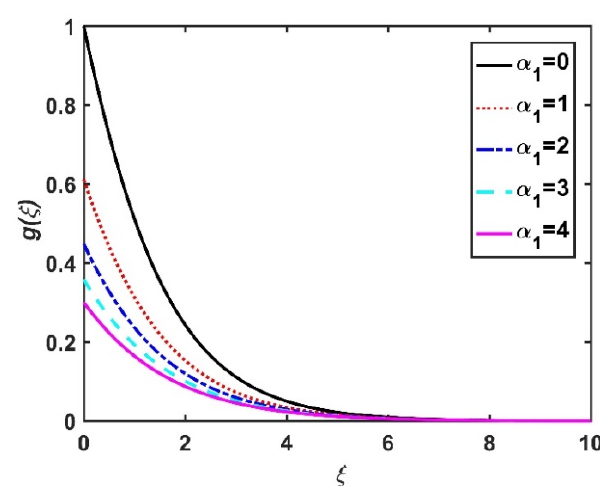
Figure 7. Impact of 𝛼 (cid:2869) on 𝑔(cid:4666)𝜉(cid:4667) . 4.2. Temperature Profile ( 𝜃(cid:4666)𝜉(cid:4667) )